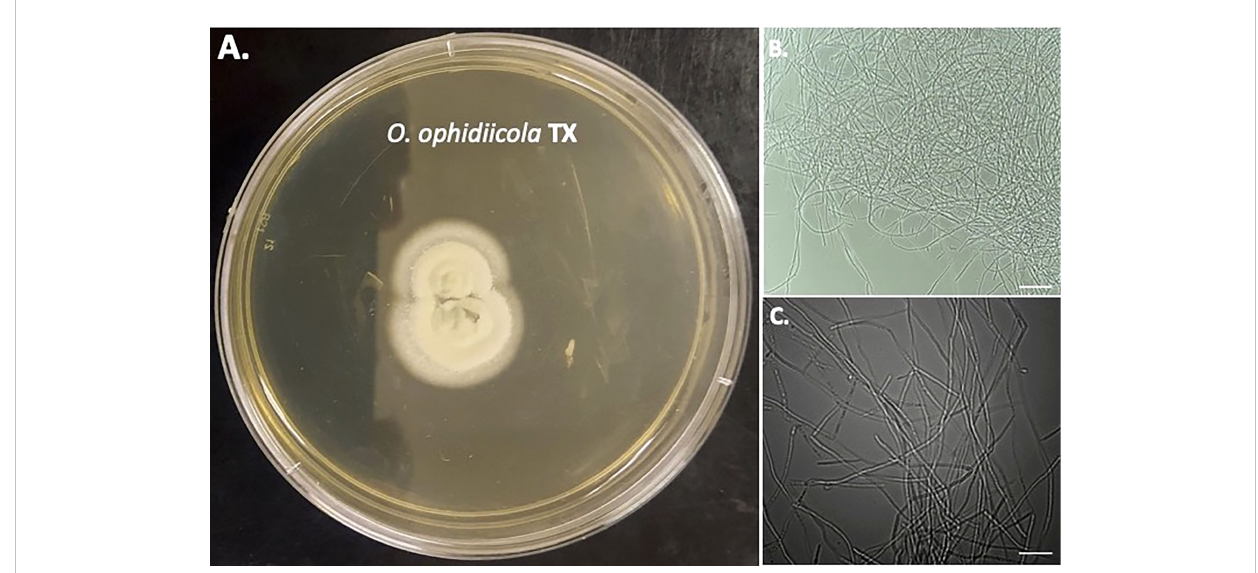
FIGURE 5 Colony and Microscopic Features of O. ophidiicola TX. Comparison of colony formation SDA plates: O. ophidiicola TX (A) Light microscope images of hyphae phase: O. ophidiicola TX (B, C) . Bars: B = 150 m m; C = 75 m